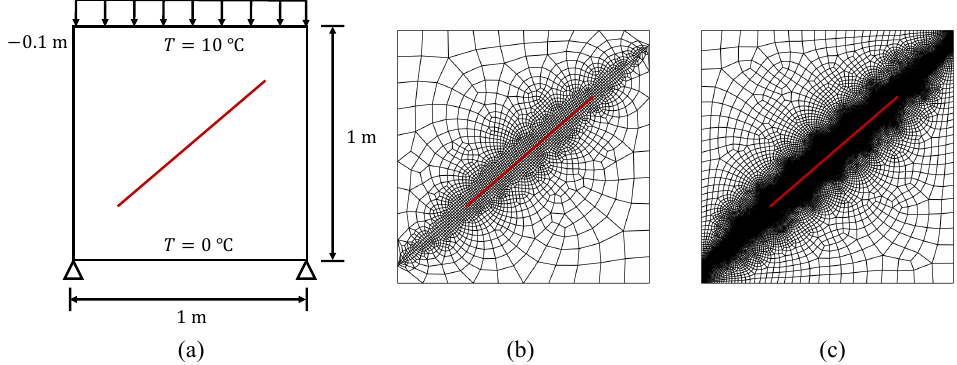
Figure 7. Description of the inclined crack problem: ( a ) boundary conditions and geometries; ( b ) coarse mesh distribution; ( c ) fine mesh